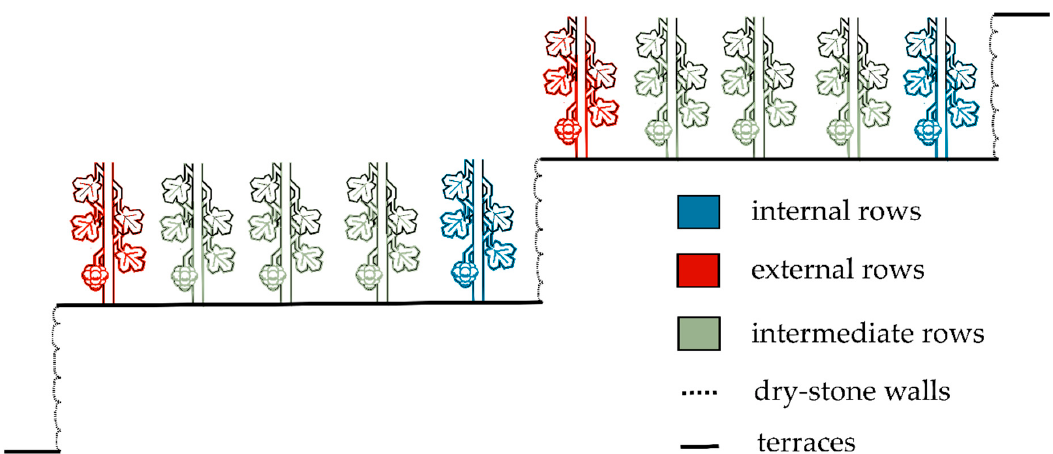
Figure 3. Each vineyard row has been labelled as: internal (blue) for the closest rows to the dry-stone wall (dotted line), external rows (red) for the ones at the edge of the terrace (black lines). All the rows comprised between internal and external have been identified as intermediate (green).